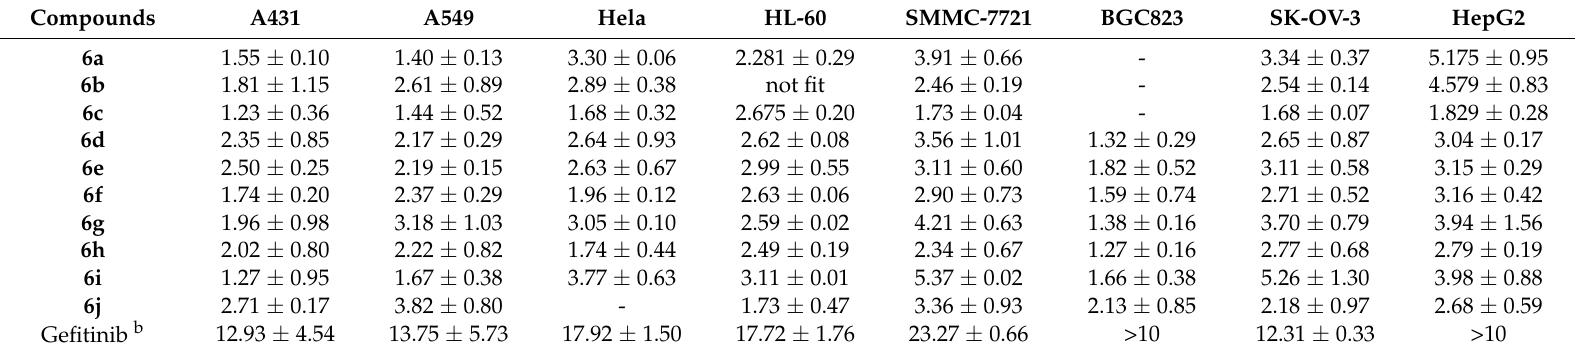
Table 1. IC 50 values of compounds 6a – 6j a and Gefitinib against eight tumor cell lines ( µ